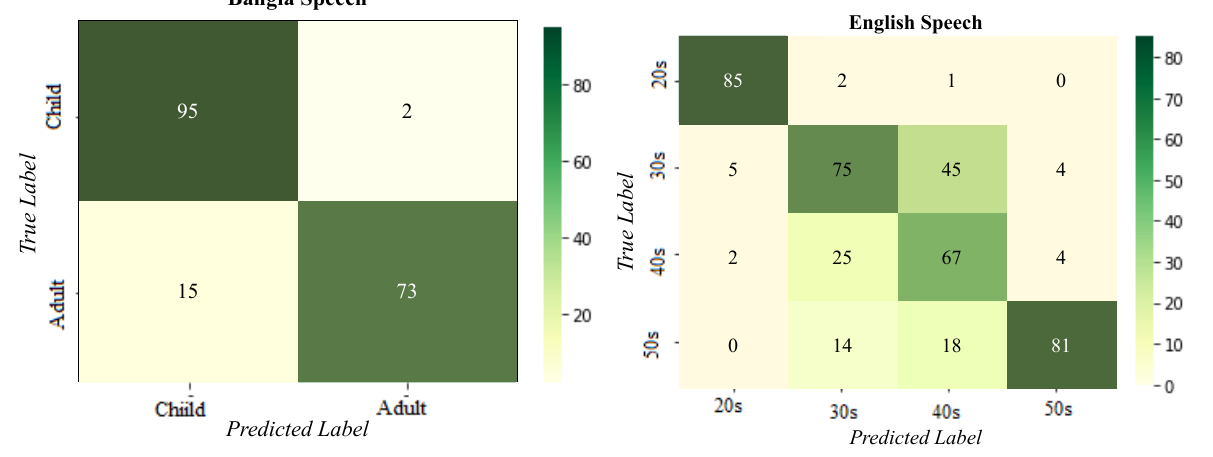
Figure 8. Confusion matrices of Age for Bangla and English Speech.